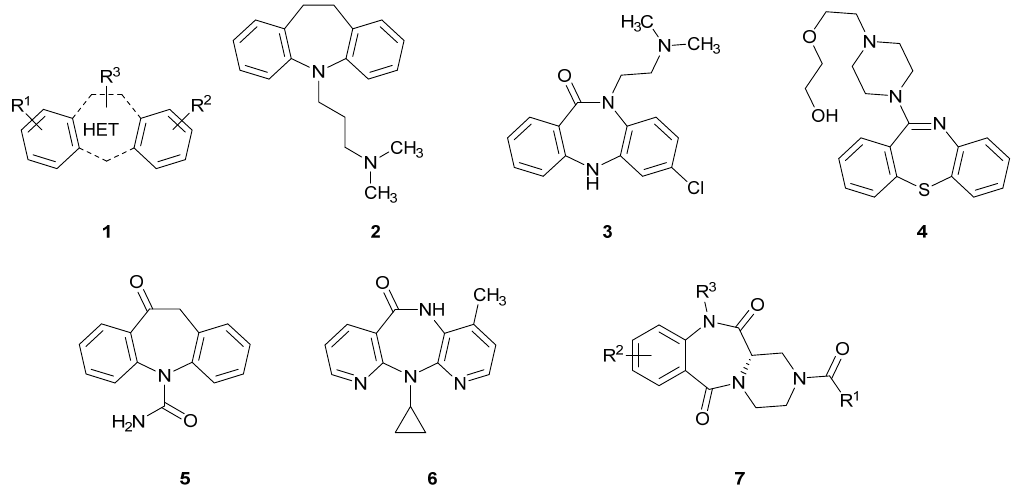
Figure 1. Tricyclic 7-th membered dibenzoheterocycles and their analogues.